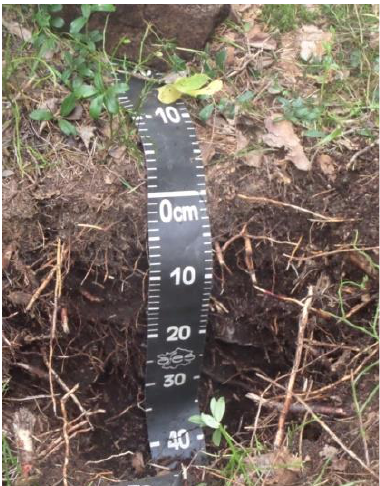
Figure 5. The photo of Dry-histic lithozem formed on rock material (Histic Leptosol — WRB).